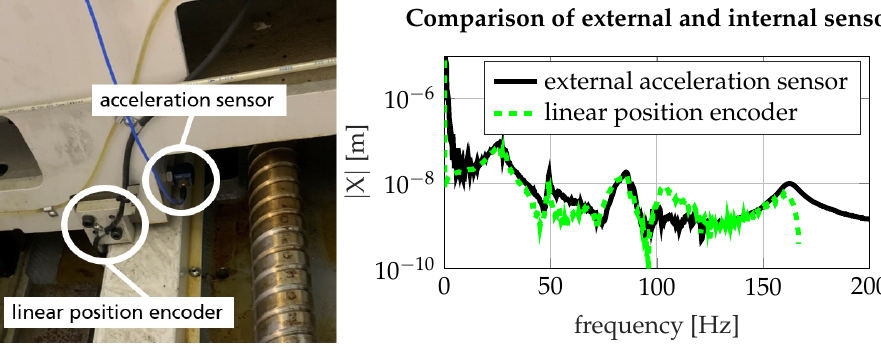
Figure 5. Comparison of double-integrated acceleration and internal position